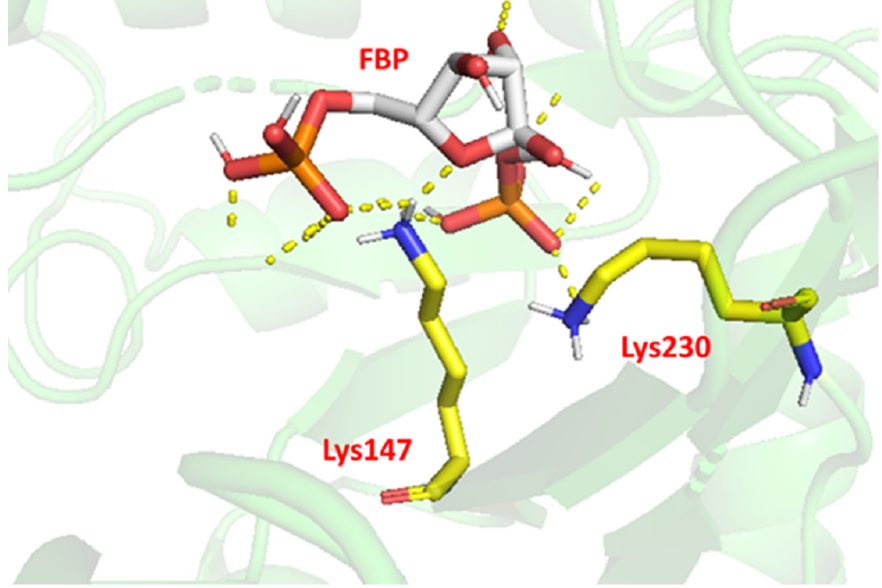
Figure 7. Substrate hydrogen-bonding simulation diagram. Yellow dashed lines represent the hydrogen bonds interacting with the substrate fructose-1,6-bisphosphate (FBP), where Lys147 and Lys230 are hydrogen-bonded to the substrate.